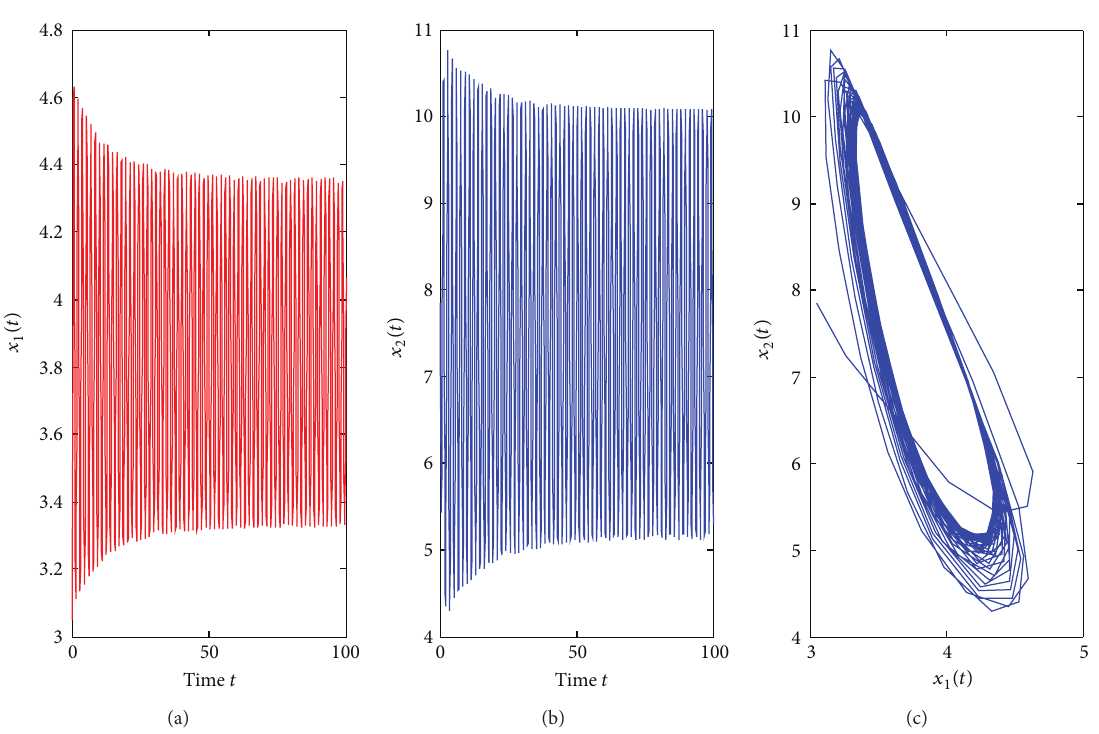
Figure 6: 𝐸 ∗ is unstable for 𝜏 = 0.355 > 𝜏 0 = 0.3361